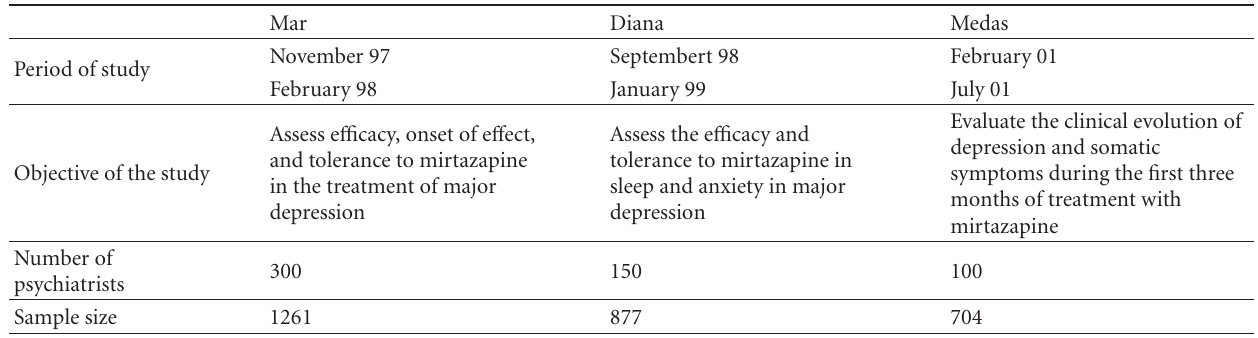
Table 1: General characteristics of the three